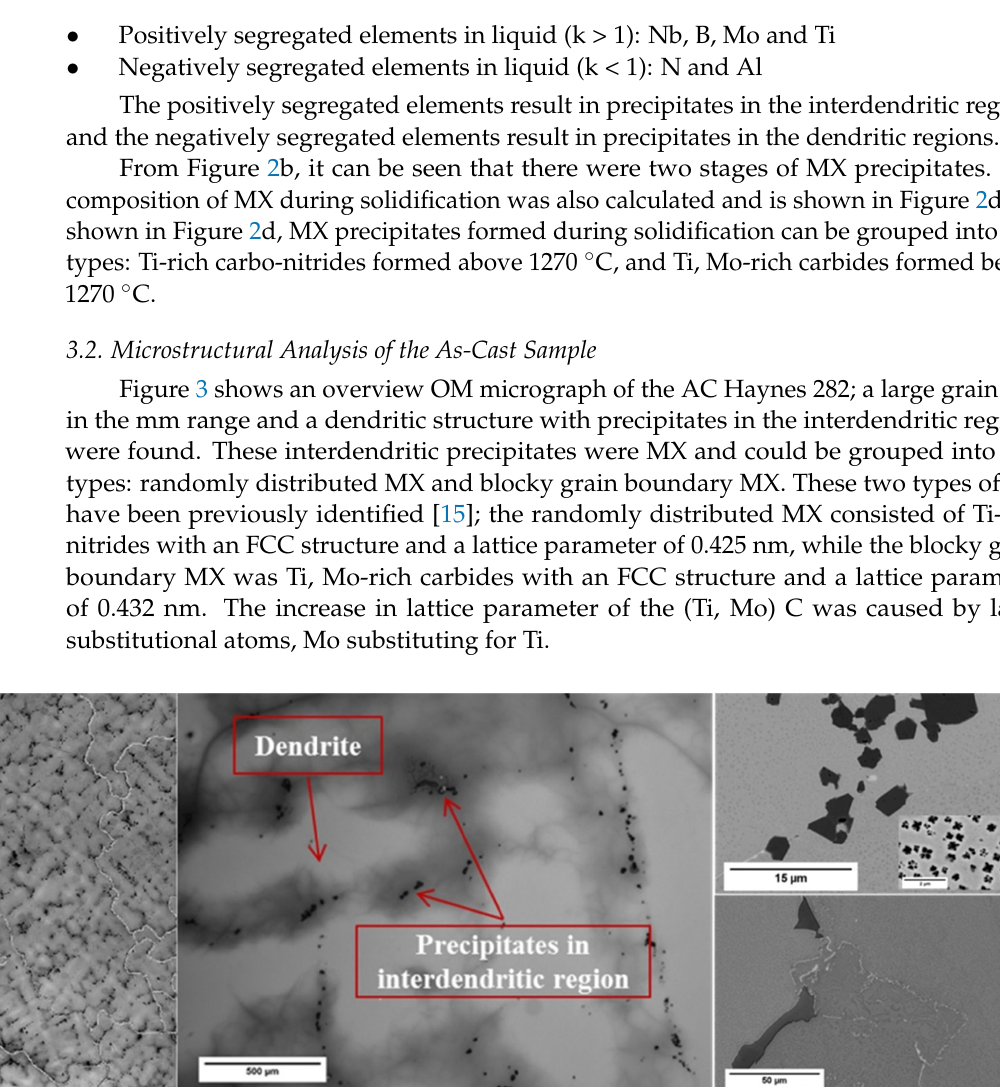
Figure 2. Thermodynamic predictions: ( a ) equilibrium state phase diagram, ( b ) solidification sequence, ( c ) element distri- bution in liquid during solidification, and ( d ) composition of predicted MX during solidification.